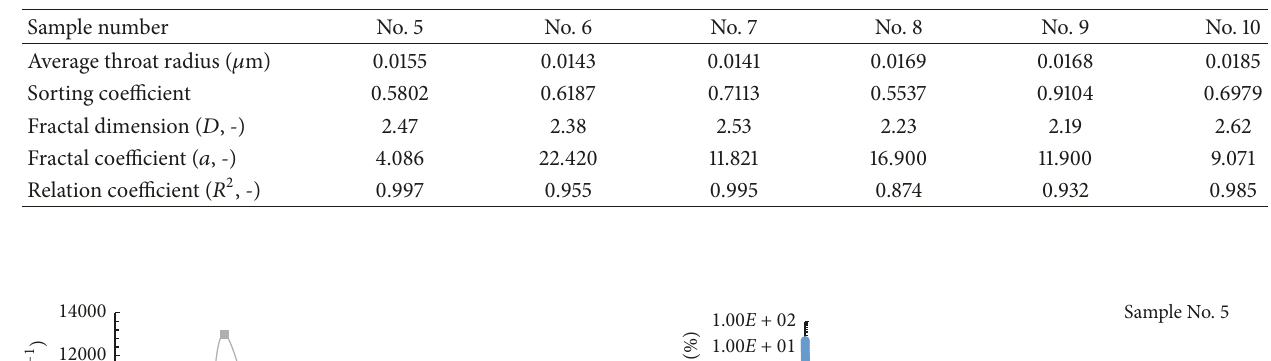
Table 4: Major parameters for the distribution of pore throat.